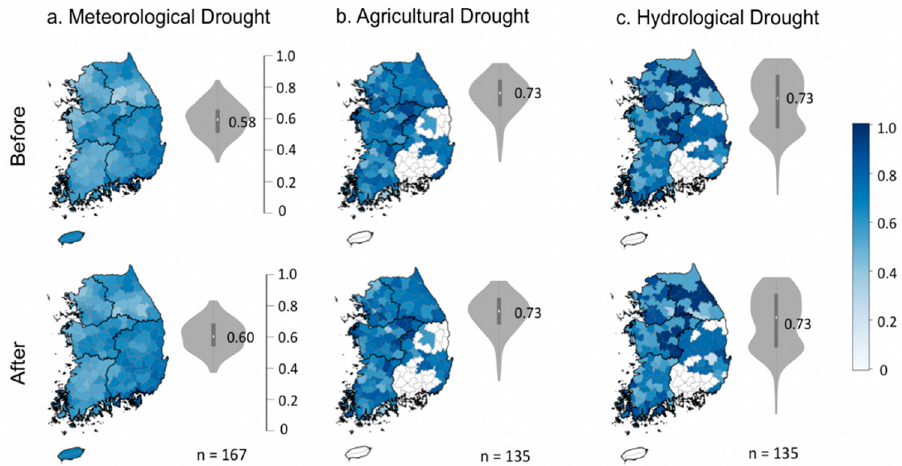
Figure 3. Specificity distribution of the ground data-based drought index (before and after weight correction).